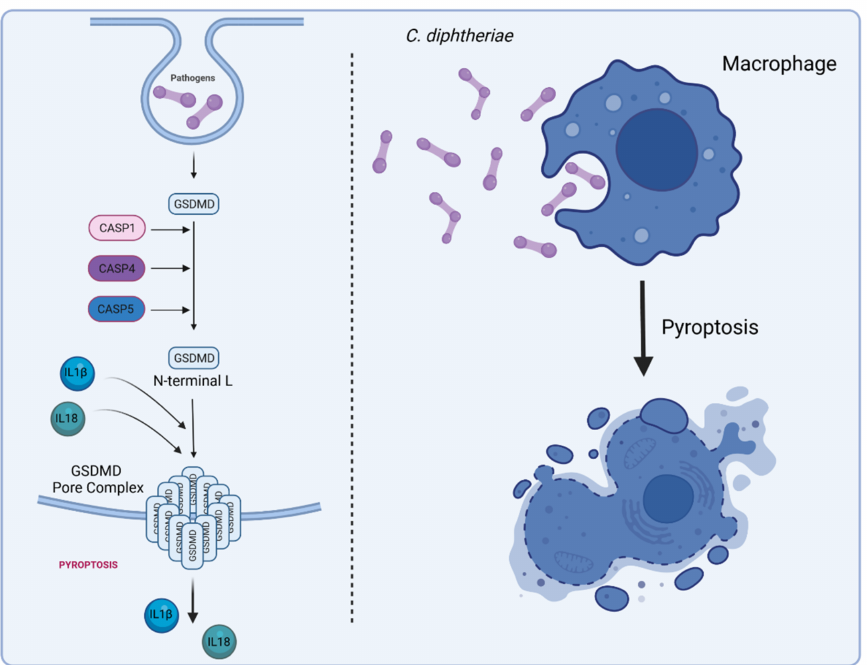
Figure 7. C. diphtheria -induced pyroptosis in macrophages. Gasdermin D (GSDMD) serves as a specific substrate of caspase-1, -4, -5 (in humans), and -11 (in mice) and as an effector molecule for the lytic and highly inflammatory form of pyroptosis [95,96]. The pore-forming activity of the N-terminal cleavage product causes cell swelling and lysis to prevent intracellular pathogens from replicating, leading to the release of cytoplasmic content such as the inflammatory cytokines IL-1 β and IL-18 into the extracellular space to recruit and activate immune cells to the site of infection [97] (figure created with BioRender.com).